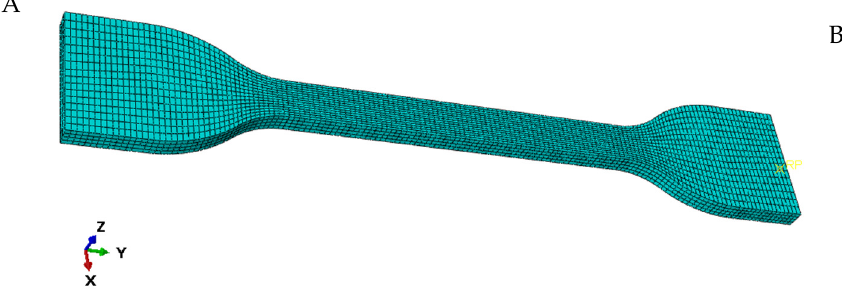
Figure 9. Uniaxial tensile specimen model and meshing.